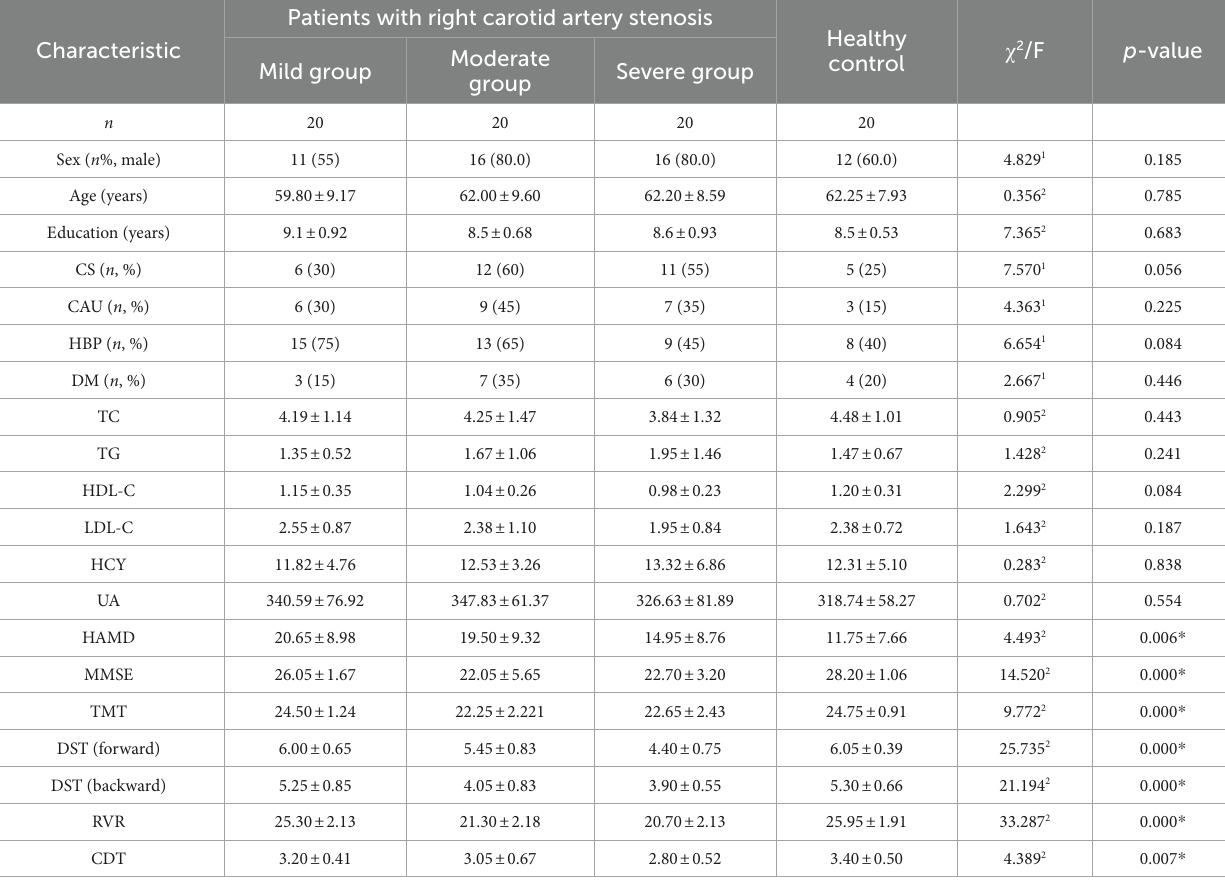
TABLE 2 Differences of clinical risk factors and neuropsychological examinations of patients with right carotid artery stenosis. Patients with right carotid artery stenosis Healthy 2 /F p -value Characteristic Moderate control χ Mild group Severe group group